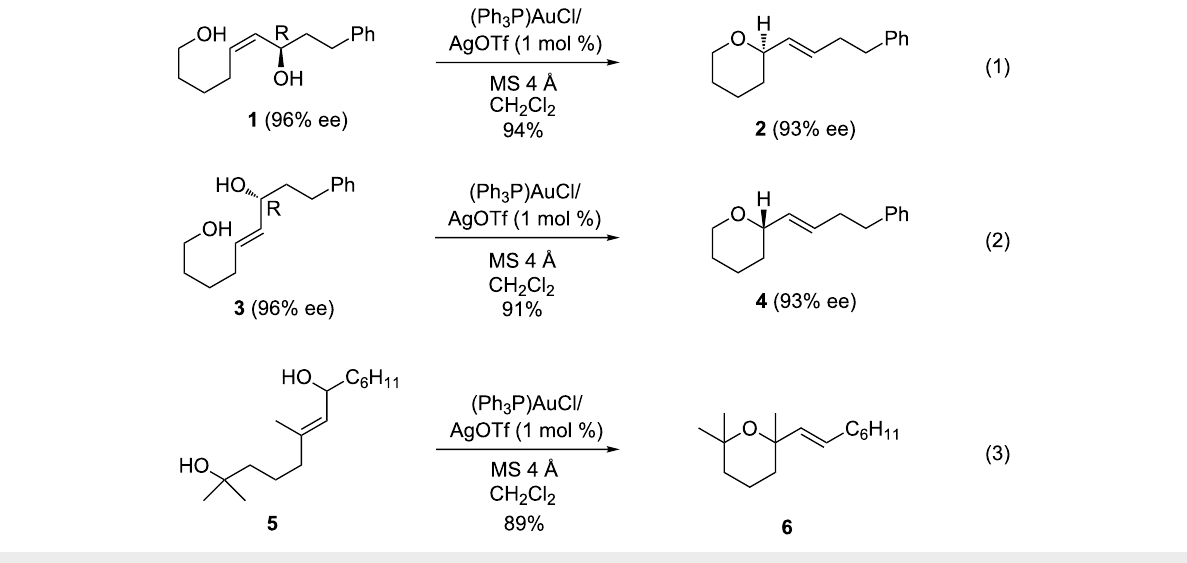
Scheme 1: Au-catalyzed cyclization reactions of monoallylic